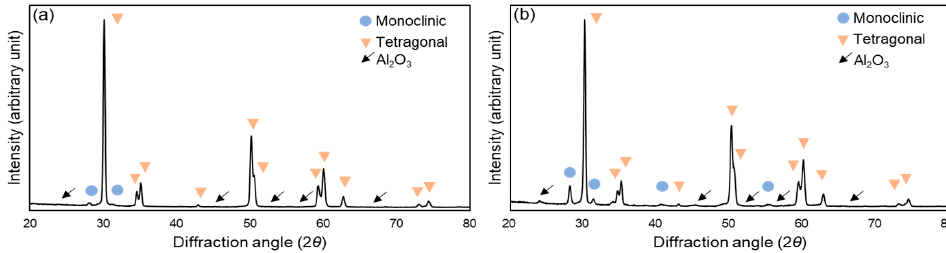
Figure 2. XRD patterns of the SM ( a ) and SLA ( b ) Y-TZP ceramics. Peaks of monoclinic and tetragonal phases were identified by ICDD card no. 01-078-0047 and 01-088-1007, respectively. Al 2 O 3 was also identified by ICDD card no. 04-013-1687.